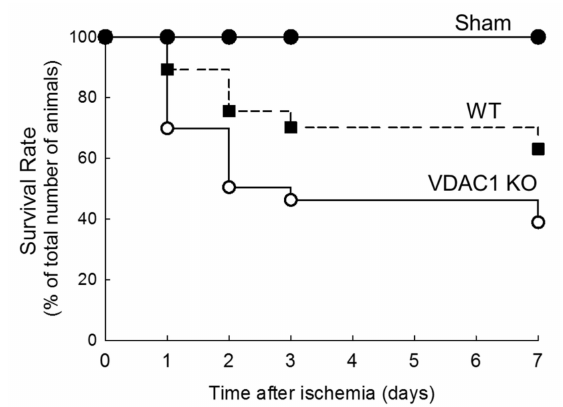
Figure 5. Deletion of VDAC1 decreases survival rate after ischemia-induced acute kidney injury. The comparison of survival of wild type (WT) and VDAC1-deficient (VDAC1 KO) mice subjected to bilateral ischemia (35 min) followed by reperfusion.